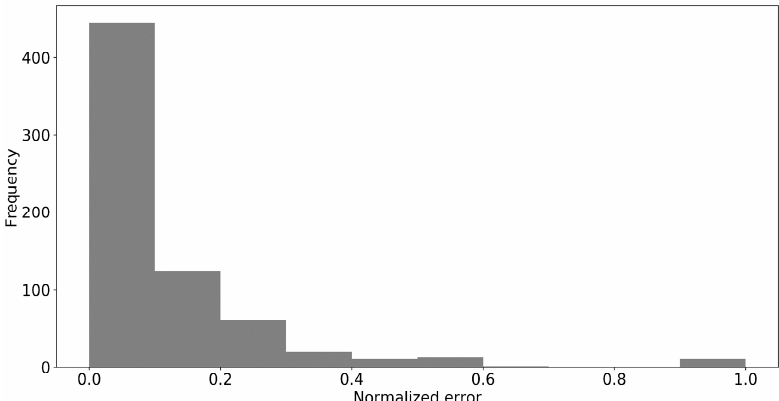
Figure 14. Histogram of normalized counting error for the image patches in both datasets.